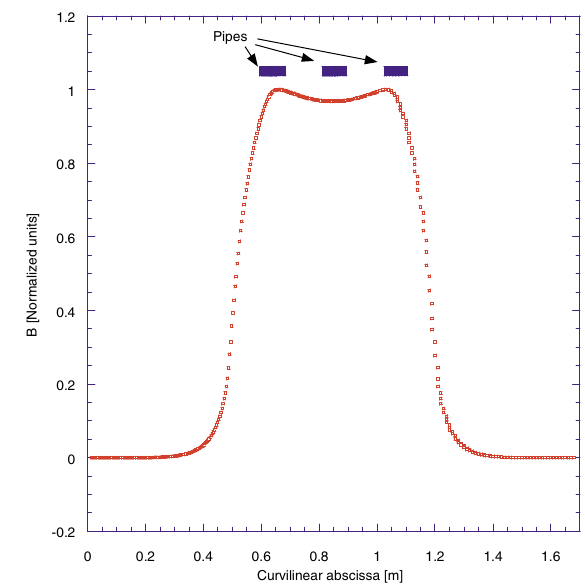
FIG. 4. (Color) Performance comparison computed for a TRASCO (cid:11) (cid:3) 0 : 85 cavity. Simulation parameters are f (cid:3) (cid:3) 10 n(cid:22) , Cu thickness (cid:3) 6 mm , 343 MHz , G (cid:3) 250 (cid:22) , R res and RRR (cid:3) 275 . ( A ) and ( B ) are, respectively, bath and pipe (cid:3) 1 : 8 K , ( C ) and ( D ) are bath and pipe cooled at cooled at T l He (cid:3) 4 : 2 K . T l He